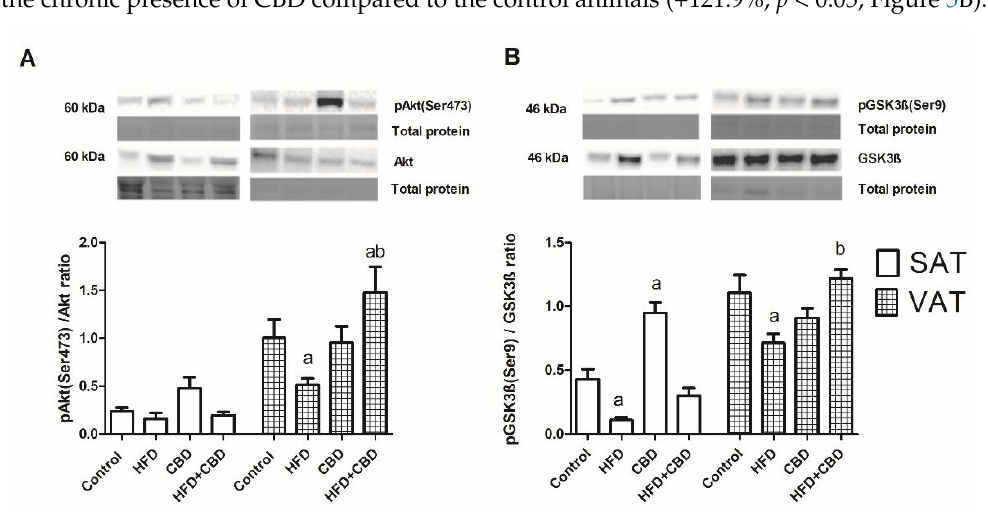
Figure 5. The total expression of proteins belonging to the insulin signaling pathway, e.g., ( A ) pAkt (Ser 473)/Akt and ( B ) pGSK3ß (Ser9)/GSK3ß, in the subcutaneous (SAT) and visceral (VAT) adipose tissues of rats fed a standard diet (control) or high-fat diet (HFD) after chronic cannabidiol (CBD) treatment. The total expression of the above proteins was standardized to the total protein expression, and the control group was set to 100%. The data are expressed as mean values ± SD, n = 6 in each group. a p < 0.05: significant difference: control group vs. experimental group; b p < 0.05: significant difference: HFD vs. HFD+CBD.